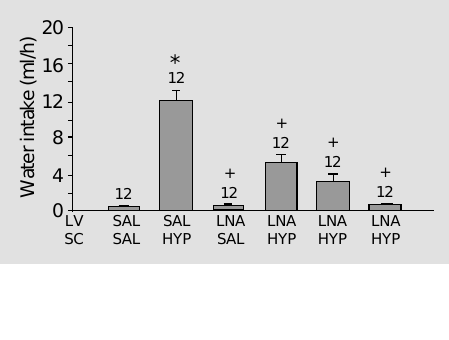
Figure 2 - Water intake after in- jection of saline (SAL) (control - lateral ventricle (LV) and subfor- nical organ (SFO)), ANG II injec- tion into the LV, and L-NAME (LNA) injection into the SFO. L- NAME was used at doses of 10, 20 and 40 µg/µl. The number of animals is indicated at the top of each column. *P<0.05 com- pared to saline; + P<0.05 com- pared to ANG II injected into the LV (Dunnett t